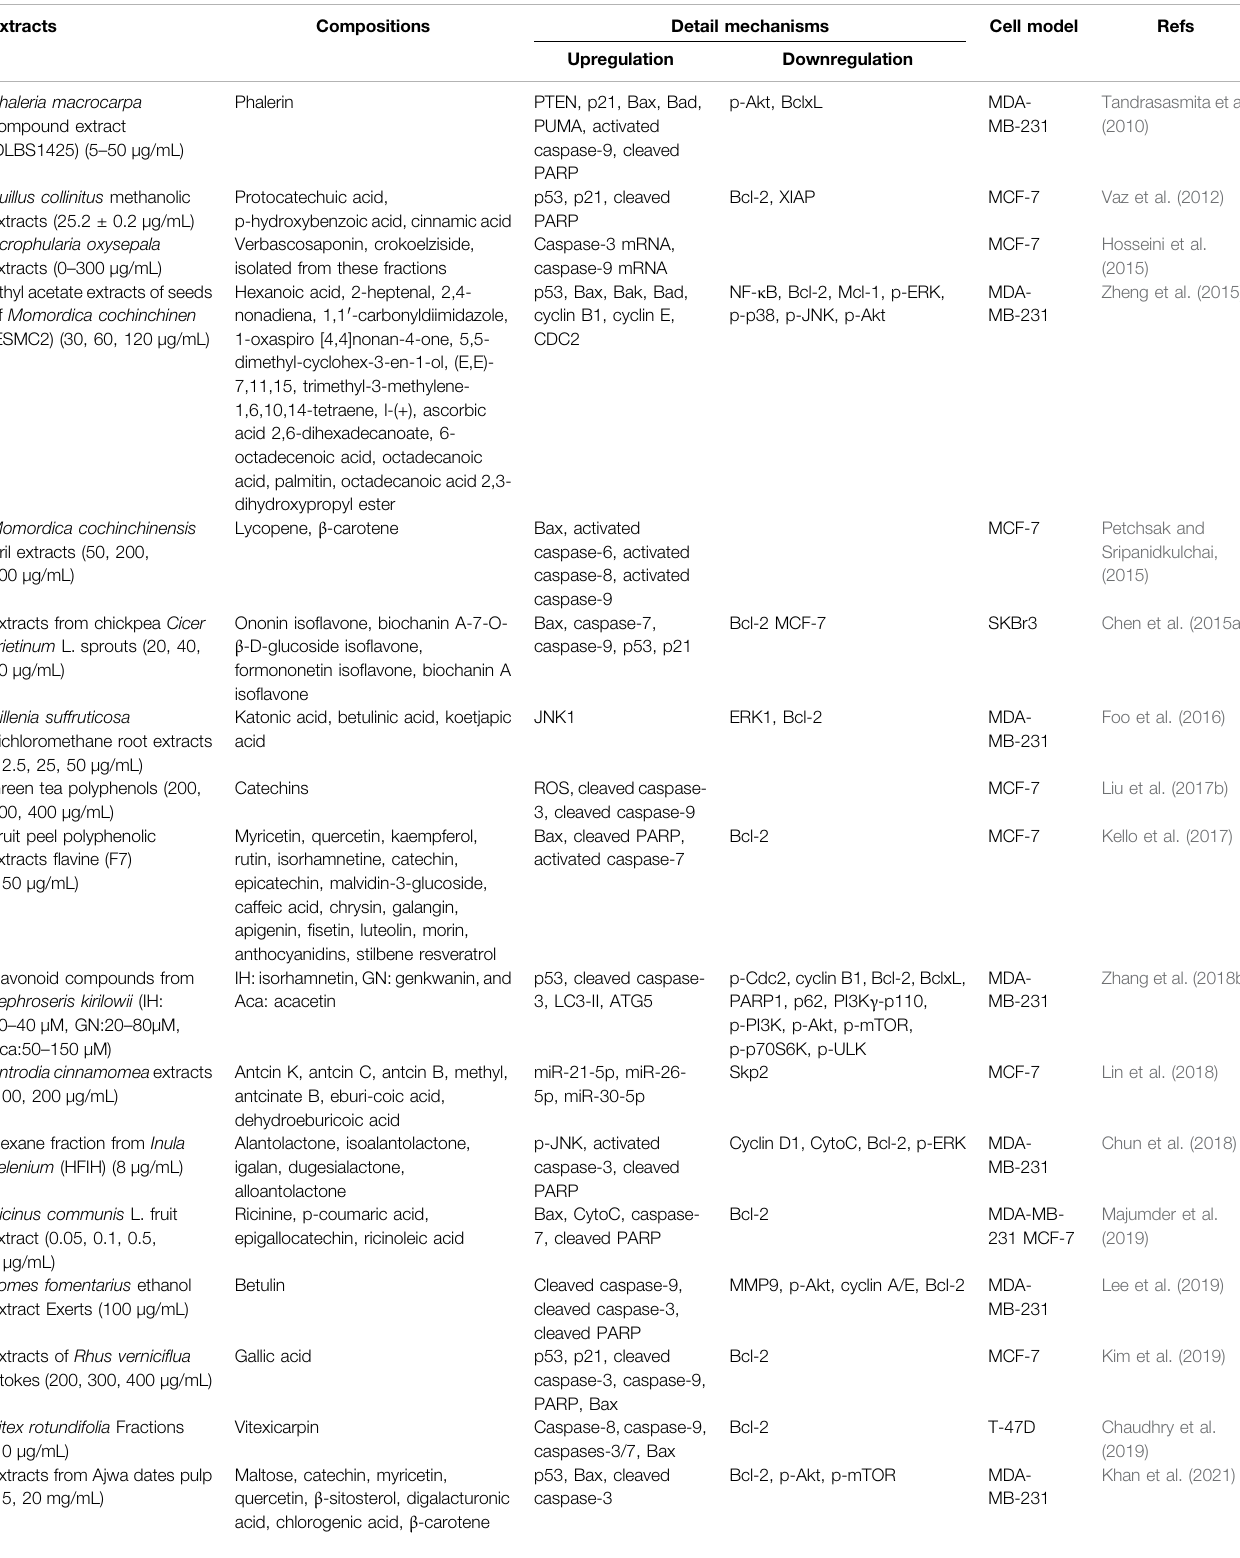
TABLE 2 | Extracts from natural products induced apoptosis in breast